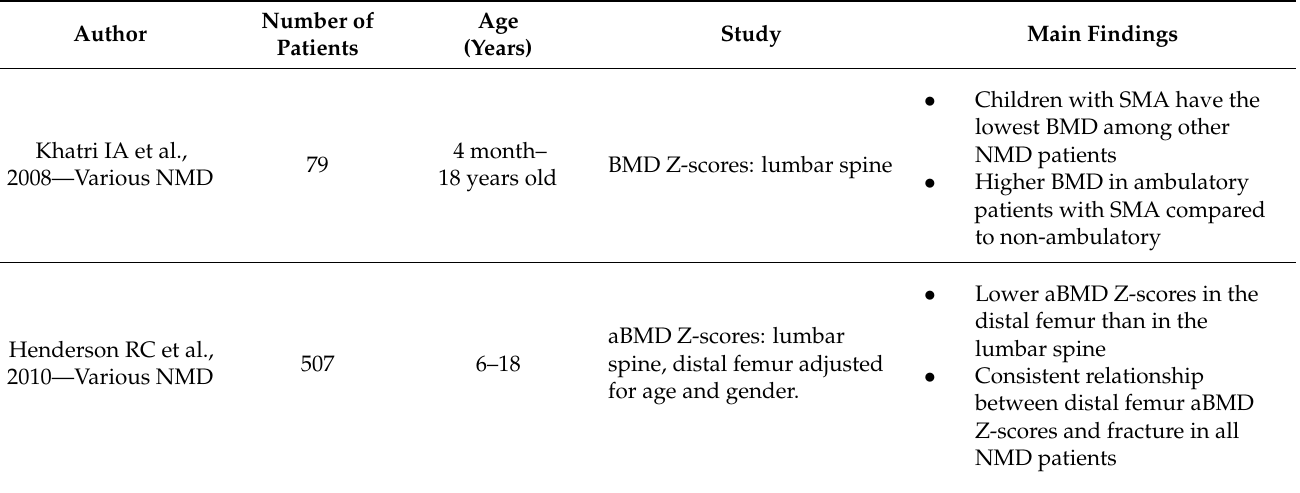
Table 3. Studies evaluating bone quality in patients with various neuromuscular